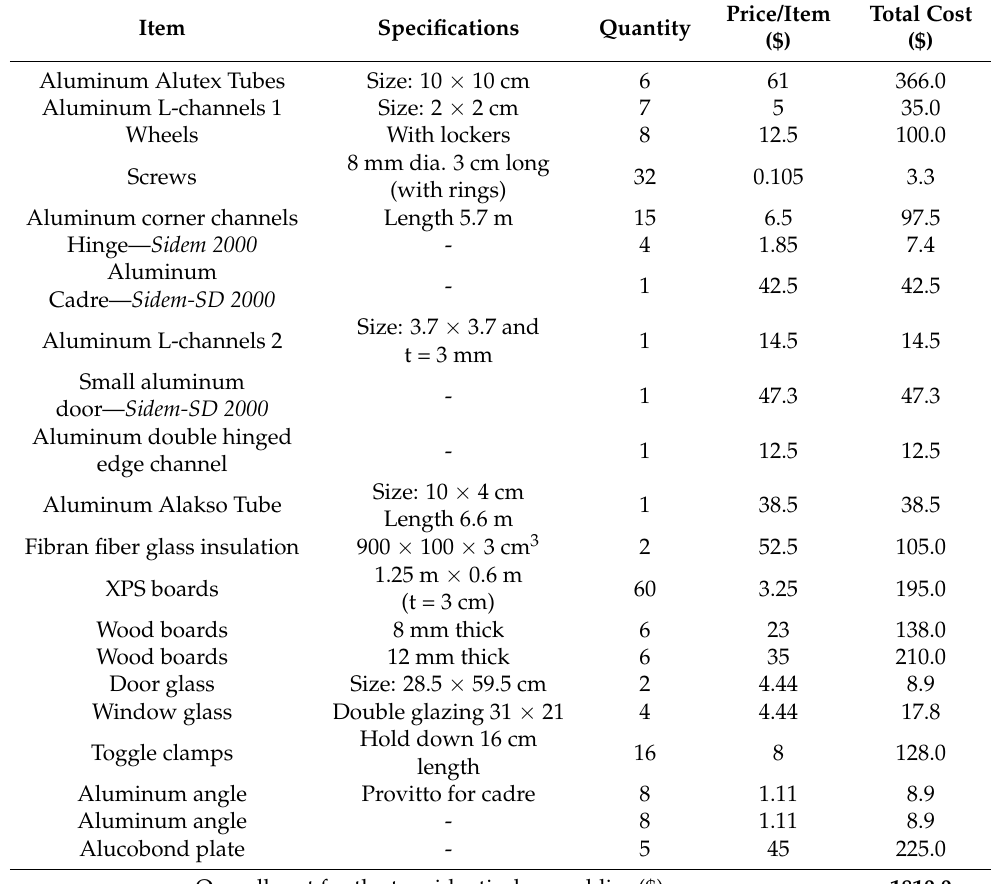
Table 6. Economical study of the two ThermoGreen prototypes showing the assembly parts, their specifications, and their respective prices.